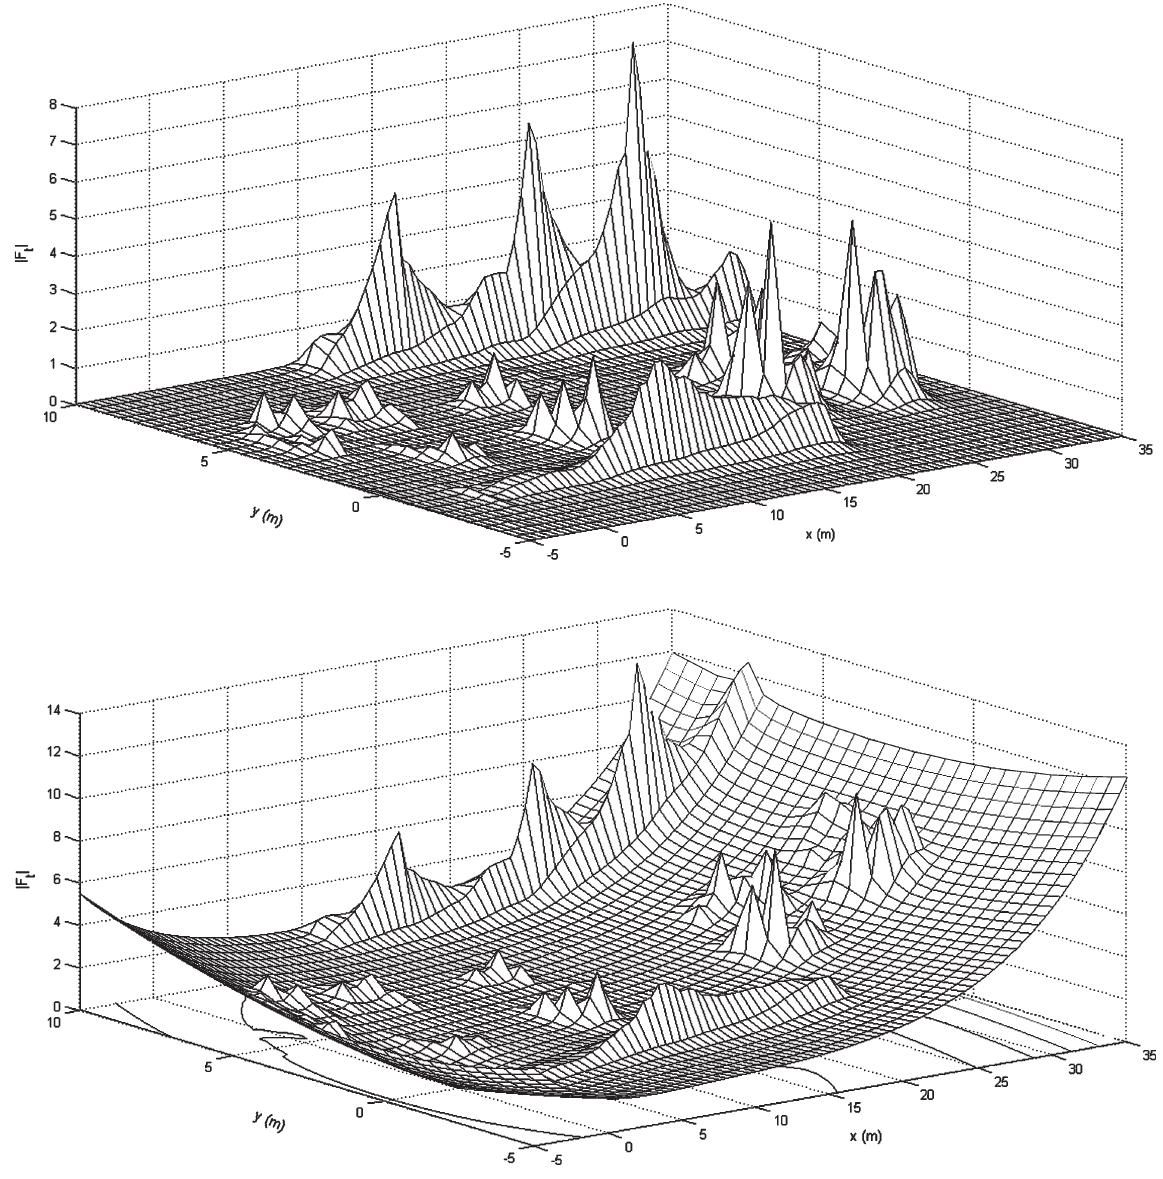
Fig. 11. Social potential fields dynamic interaction showed as 3 D outdoor global mapping yielded through an autonomous navigation task. Above: robot’s interaction in the repulsive map; Below: robot’s interaction with numerous potential fields F γ + F α .